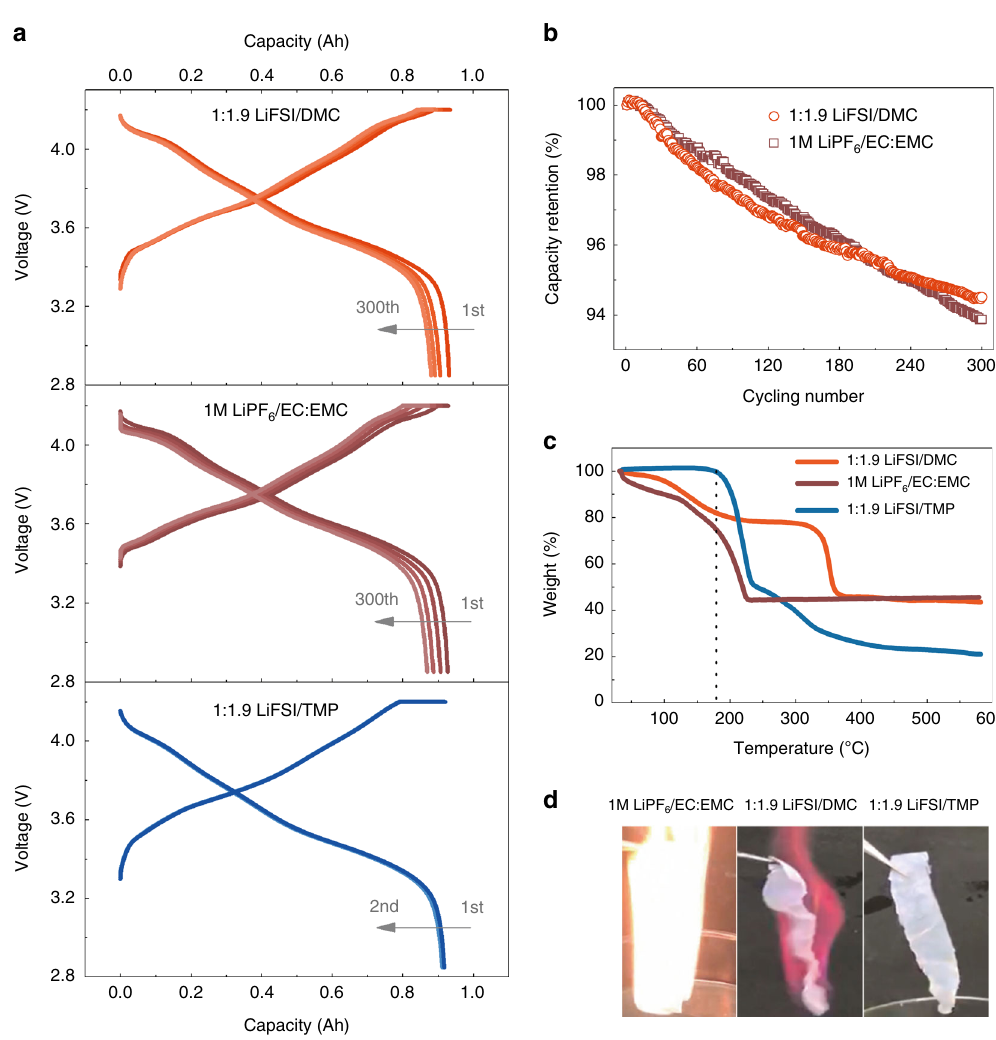
Fig. 1 Electrochemical performance and physical properties of concentrated electrolytes. a Charge and discharge plots of the Gr|NMC811 battery with LiFSI/DMC (1:1.9 by molar), LiFSI/TMP (1:1.9 by molar), and conventional 1 M LiPF 6 /EC:EMC (3:7 by volume). All batteries delivered a reversible capacity of 0.93 Ah, which was approximated to the design capacity of 0.95 Ah. b Cycling performance of Gr|NMC811 battery with LiFSI/DMC concentrated electrolyte and 1 M LiPF 6 /EC:EMC. c TGA curves showed the weight loss of the LiFSI/DMC and LiFSI/TMP concentrated electrolytes and the 1 M LiPF 6 / EC:EMC electrolyte. d Flammability of the LiFSI/DMC and LiFSI/TMP concentrated electrolytes and the 1 M LiPF 6 /EC:EMC electrolyte. Ignition tests were performed using polyethylene separators, which were saturated with the electrolytes. A fl ame igniter produced a fl ame with a temperature of above 1400 °C. The photos displayed the moment when the electrolytes were burning with the most vigorous fl